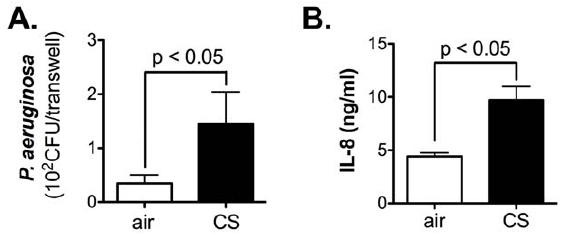
Figure 3. CS exposure impairs P.aeruginosa clearance. A. CS exposure increases P. aeruginosa colony forming units (CFU) on primary NHBE cells. B. CS exposure significantly enhances IL-8 secretion in the basolateral supernatant of primary NHBE cell cultures. Data are representative of 3 independent experiments and are expressed as mean 6